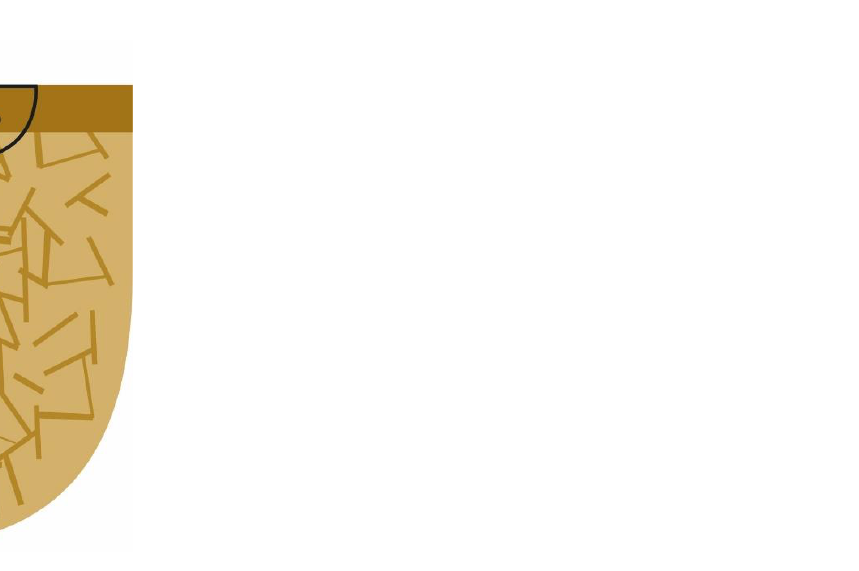
Figure 3. After osseointegration, the endosseous implant surface is covered by bone in direct contact. This bone corticalizes. Bone and implant are loaded on intrusion, and the angle between the outer cortical and inner cortical is sharp.